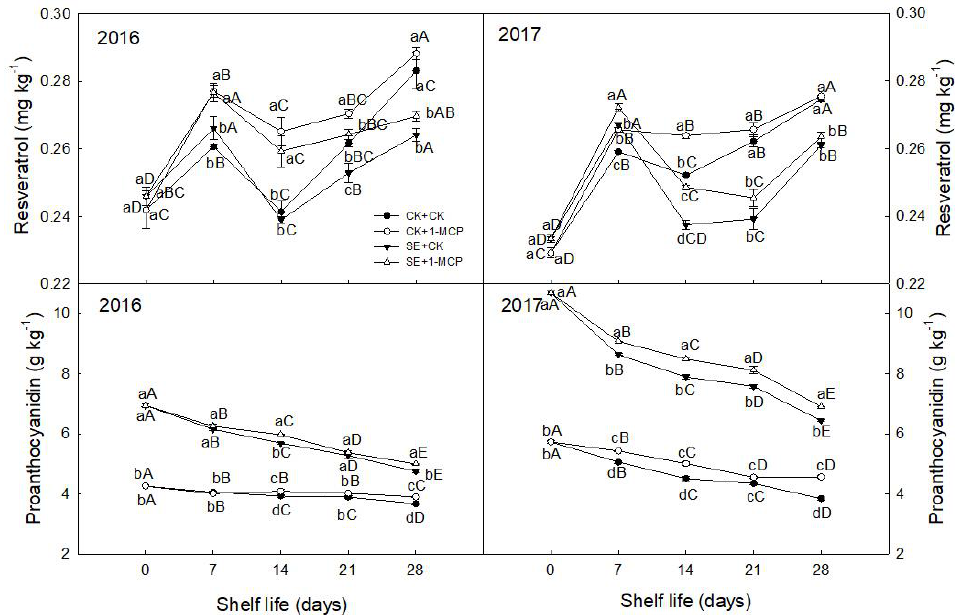
Figure 5. Dynamic changes of resveratrol and proanthocyanidin during shelf life period. Notes: CK—control treatments; SE—Se fertilizer treatments; 1-MCP—1-methylcyclopropene treatments; RES—resveratrol; OPC—proanthocyanidin. Different lower-case letters on the polyline show significant differences ( p < 0.05) between different treatments. Different capital letters on the polyline show significant differences ( p < 0.05) between different shelf life (days).